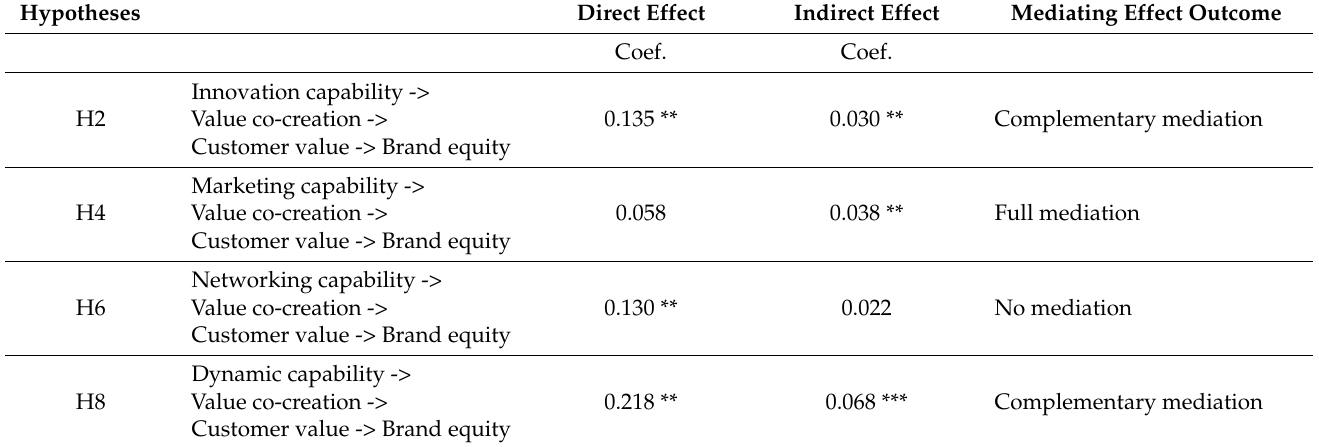
Table 9. Mediating effect